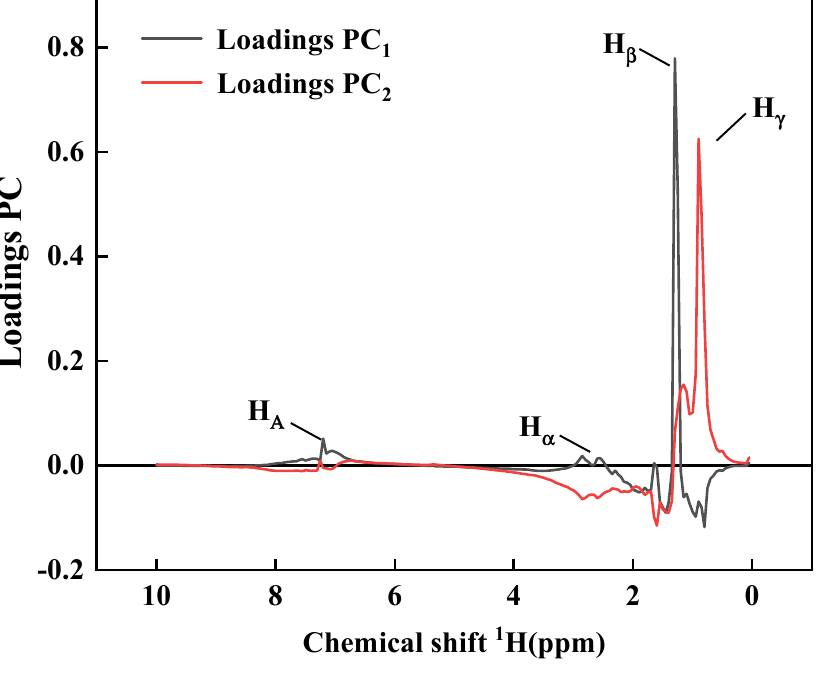
Figure 7. Loadings column Plot PC 1 and PC 2 .